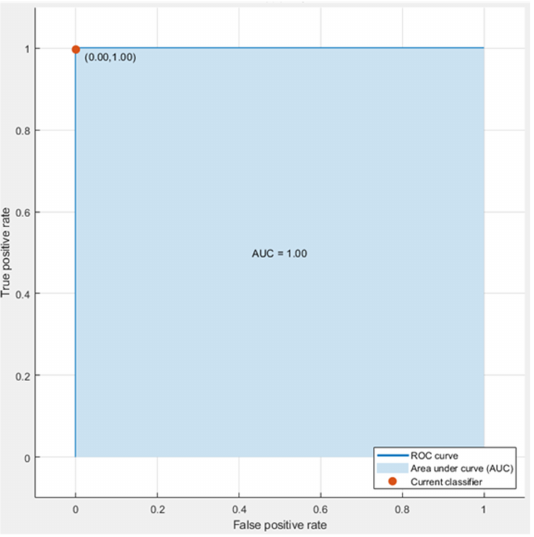
Figure 6. ROC curve of Cubic SVM on GA-optimized